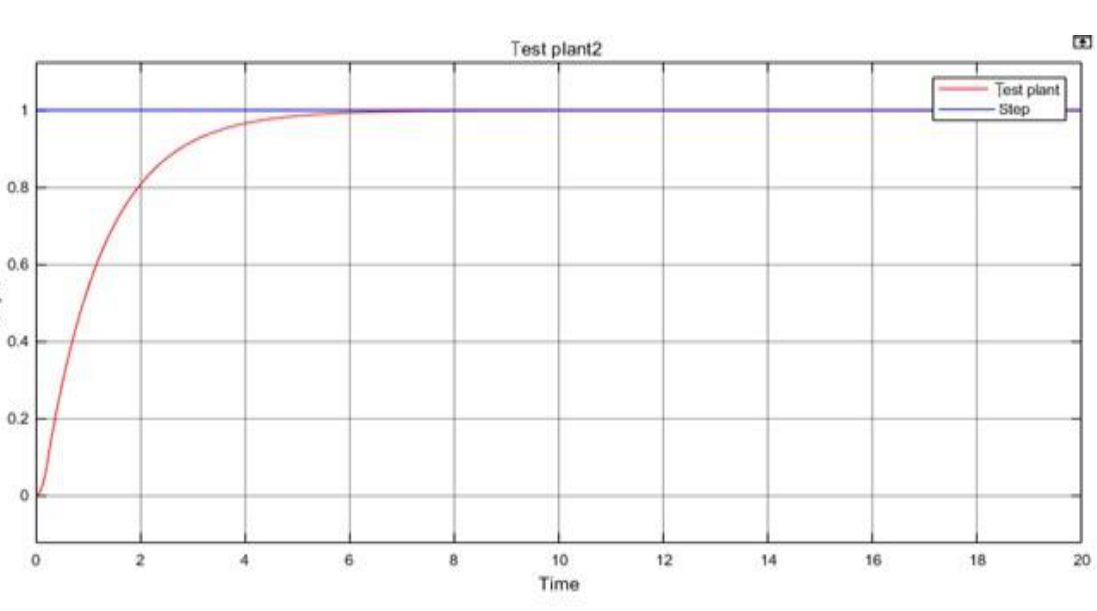
Fig. 7. Response of system with test plant 2 using